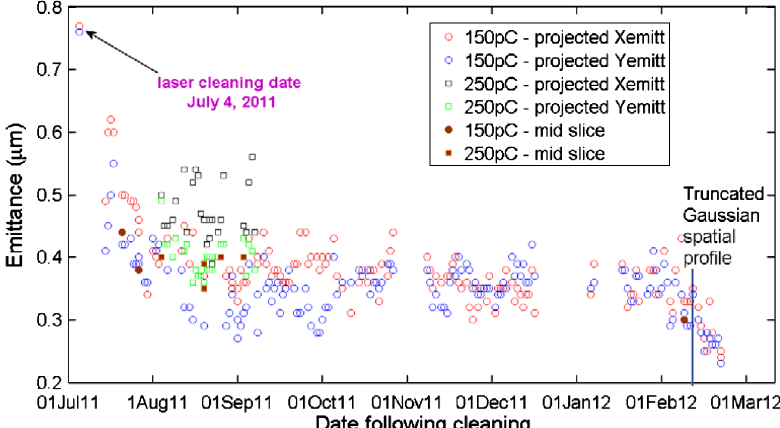
FIG. 7. Emittance evolution for the cathode spot with yellow circle: the emittance assumes a normal value, between 0.3 and 0 : 4 (cid:1) m (for 150 pC), within 2–3 weeks following the laser cleaning. The cathode spot being used for user operations is close to the cathode center. No data is shown from the middle of December 2011 to early in January 2012 since the LCLS machine was shut down. The emittance improvement after February 9, 2012 is due to use of a Gaussian-cut laser spatial profile, rather than a pseudouniform profile [13].